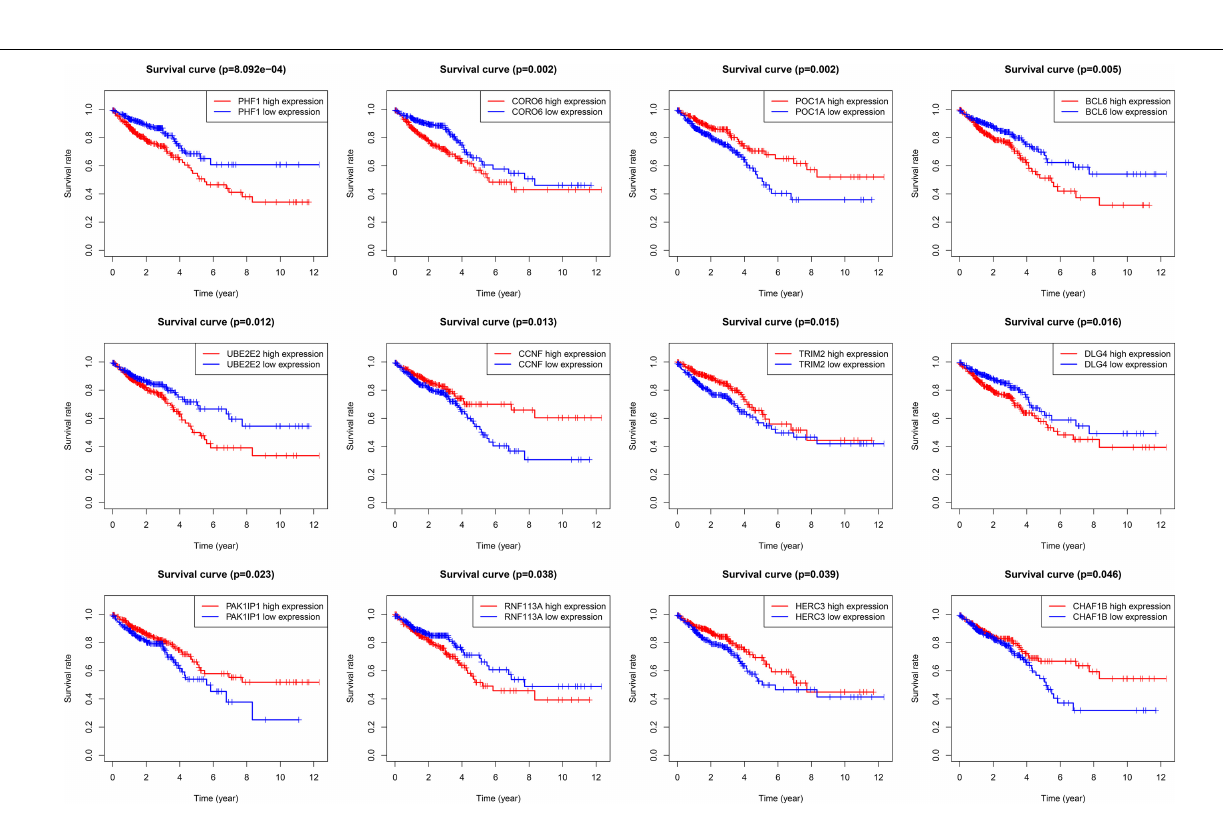
Frontiers in Cell and Developmental Biology |